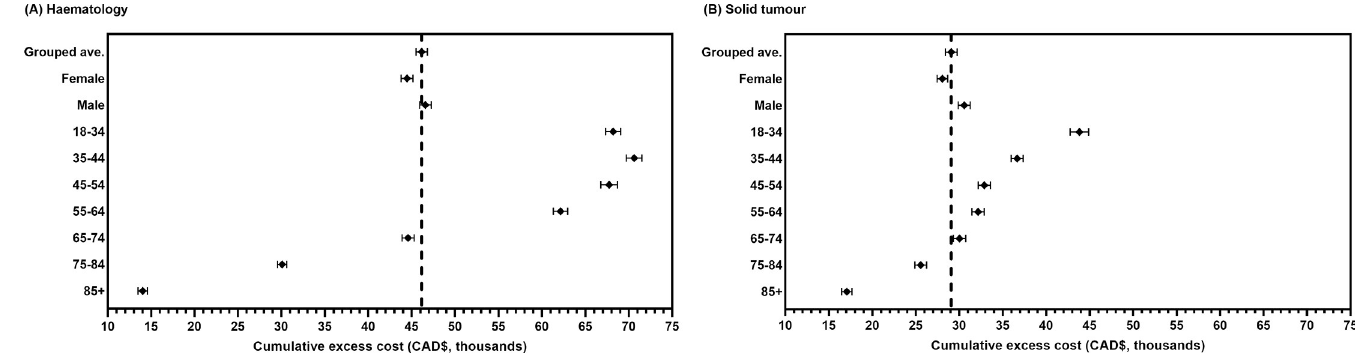
Fig 2. Variations in the 1-year cumulative excess cost by sex and age groups. (A) Haematolgy. (B) Solid tumour. The dotted vertical line represents the excess cost presented in our main analysis (overall grouped average). Error bars represent the 95% confidence